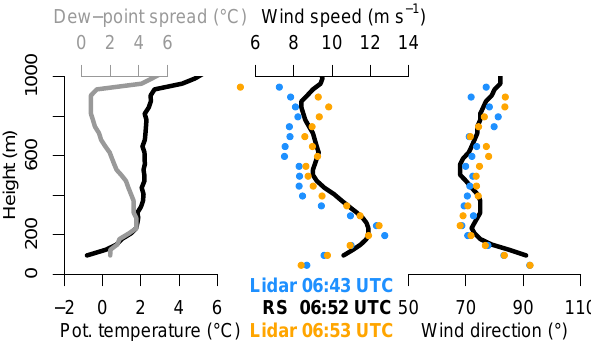
Pot. temperature Figure 12. As Fig. 10 but for the LLJ around 07:00UTC on 17 Jan- uary 2016 (PS96). A SNR threshold of − 26dB was